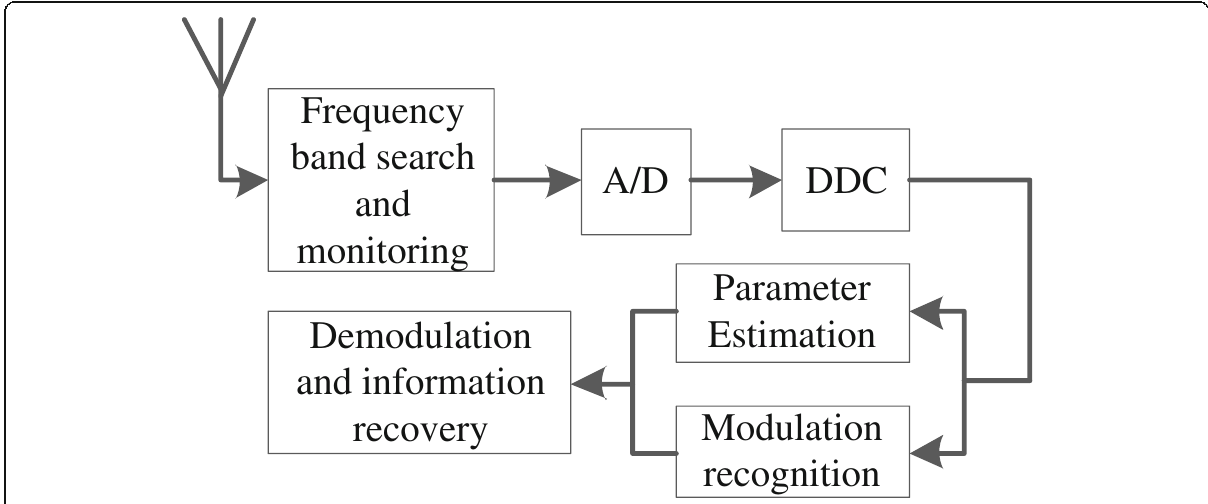
Fig. 1 Signal processing steps under non-cooperative communication